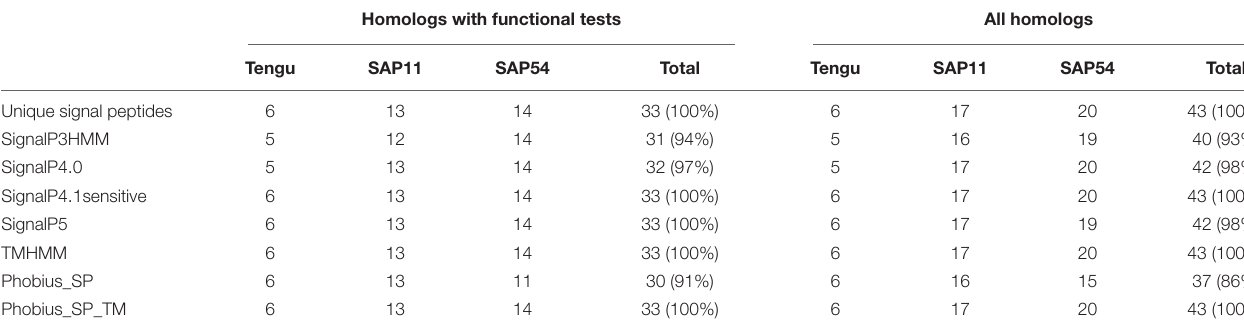
TABLE 4 | Count of positive signal peptide predictions of the protein sequences homologous to Tengu, SAP11, and SAP54. Homologs with functional tests